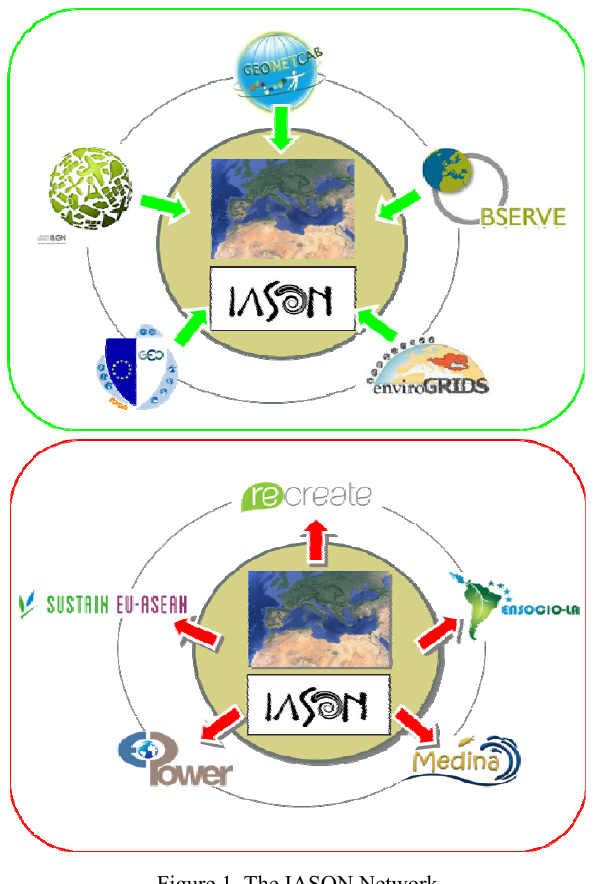
Figure 1. The IASON Network